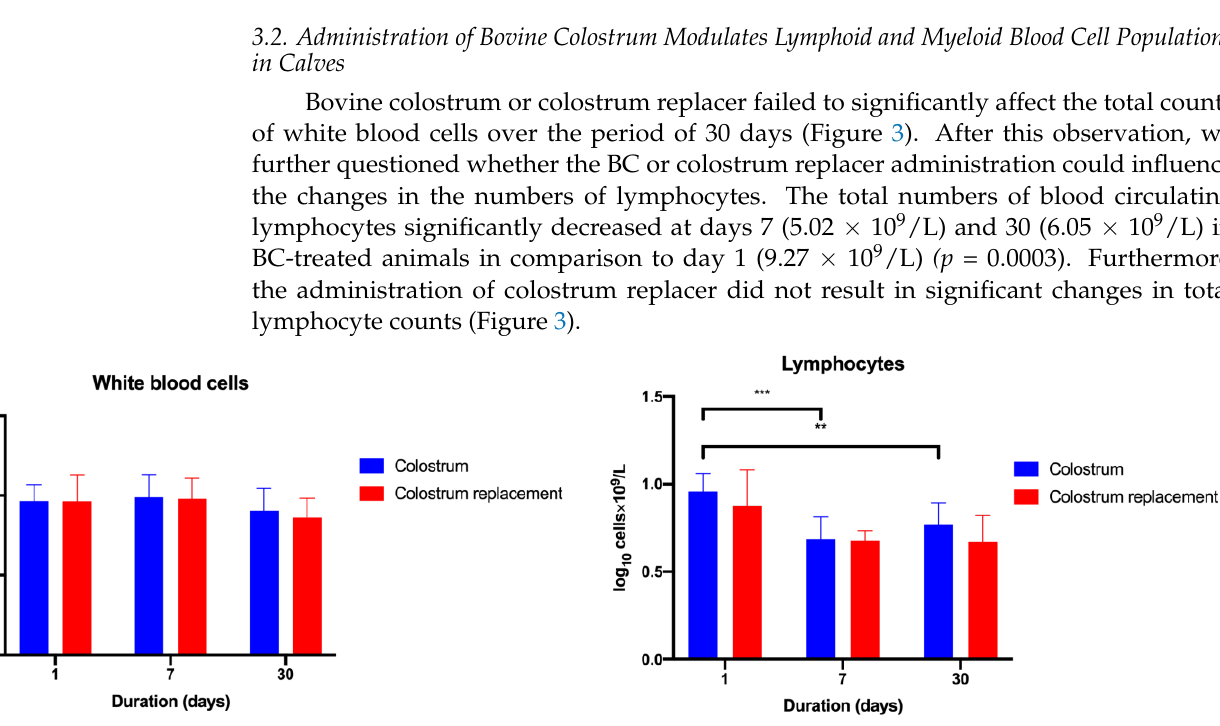
Figure 3. The administration of colostrum induces changes in lymphoid blood cell populations in calves. The experimental animals ( n = 5 in each group) received colostrum or commercial colostrum replacement for the first 6 h after birth. On days 1, 7 and 30, the venous blood was collected and analyzed. The results are shown as mean ± SEM from five experimental animals. ** p < 0.05, *** p < 0.001.